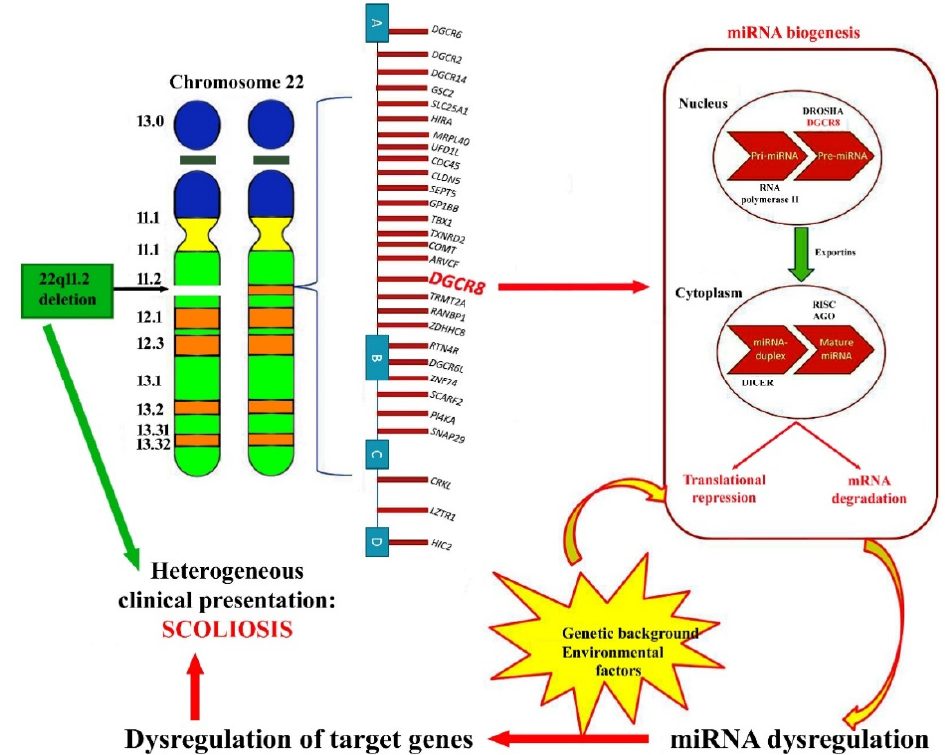
Figure 5. Schematic representation of the potential role of dysregulated miRNAs in 22q11.2DS and scoliosis. Individuals usually harbor one of three common deletion sizes (3, 2 and 1.5 Mb) between low-copy repeats (LCRs) designated as A-D, A-C and A-B, respectively, which leads to haploinsufficiency of several genes, including DGCR8 , which is involved in miRNA biogenesis. MiRNA binds to mRNA transcripts, targeting them for degradation, thus, playing a pivotal role in regulating mRNA translation. The genetic background of individual and environmental factors could interfere with miRNA expression, leading to dysregulation of their target genes.